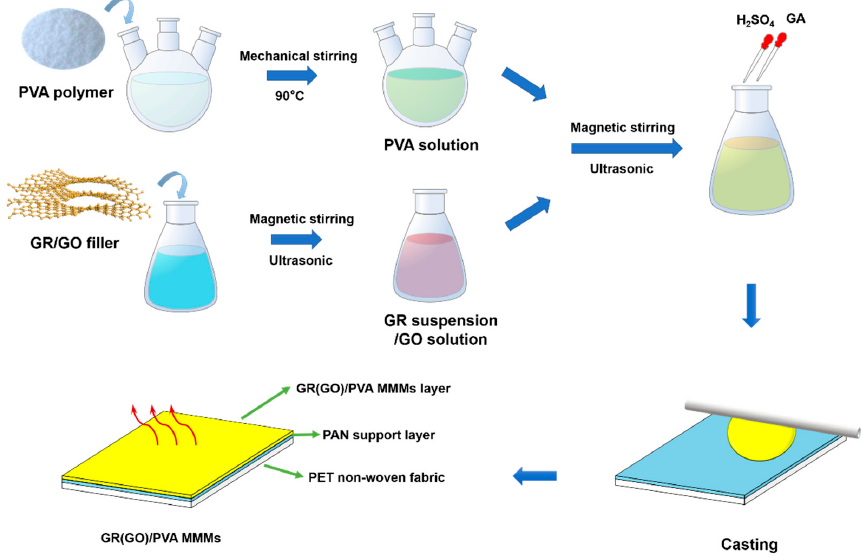
Figure 2. Preparation process of PVA-based MMMs.